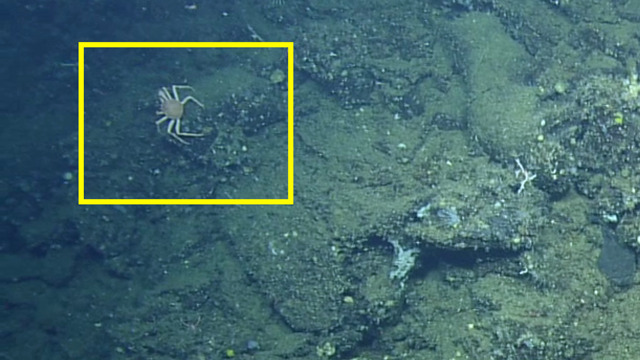
Paralomis sp. indet.